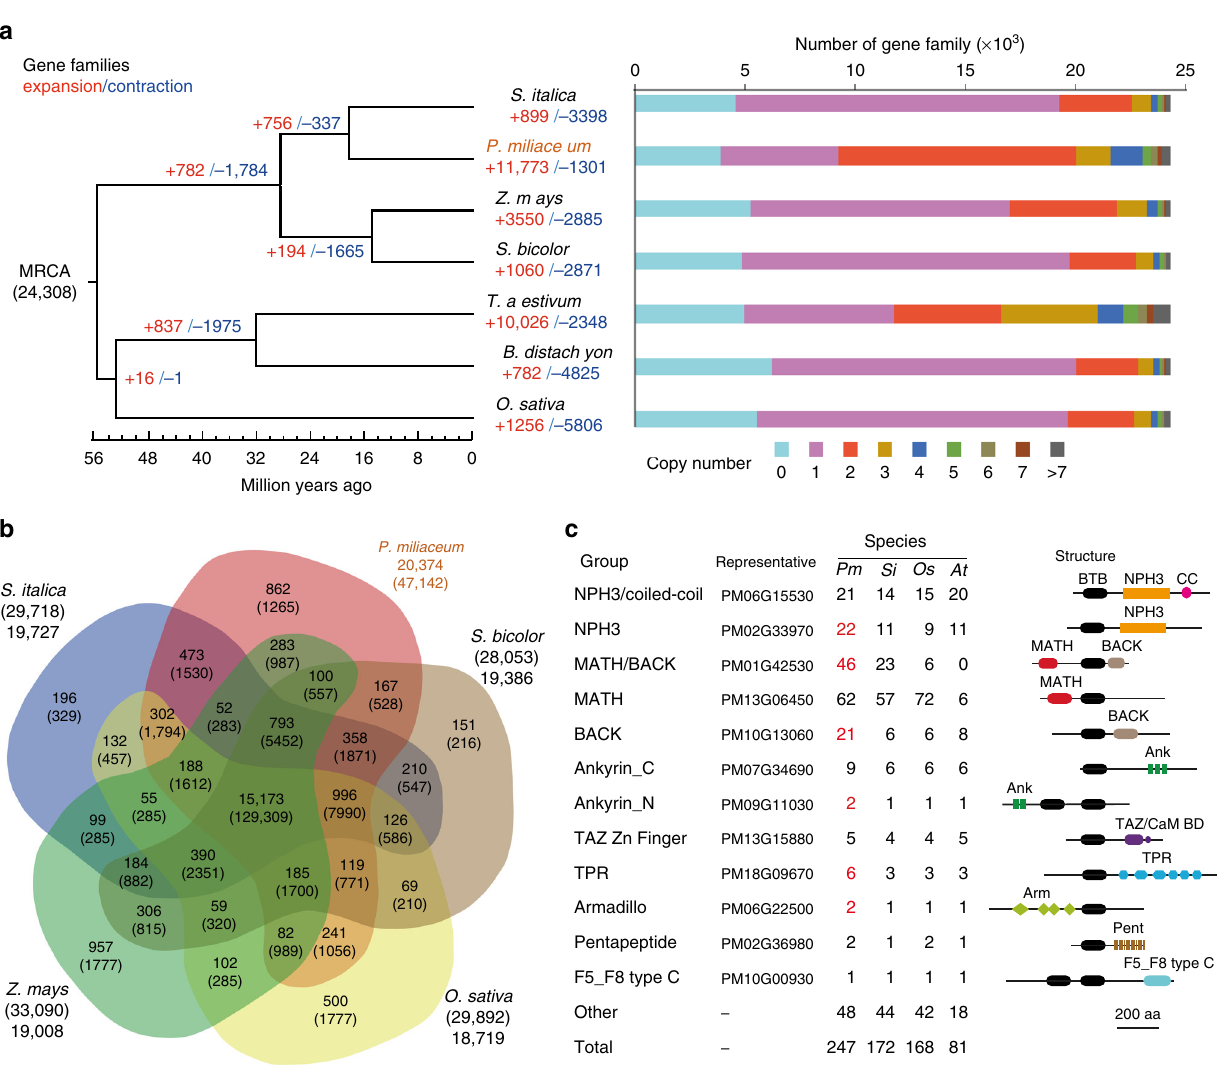
Fig. 3 Comparative genomics of gene families in broomcorn millet. a The number of gene families that expanded or contracted during evolution mapped to the species phylogenetic tree. b Overlap of gene families in broomcorn millet ( P. miliaceum ) and four other grasses. c Gene copy number and domain architecture of BTB proteins in broomcorn millet ( Pm ), foxtail millet ( Si ), rice ( Os ), and Arabidopsis thaliana (At). Gene copy numbers that are at least twofold higher in broomcorn millet ( P. miliaceum ) than in other species are labeled red. BTB broad complex/tramtrack/bric-a-brac, NPH3 nonphototropic- hypocotyl 3, MATH meprin-and-TRAF-homology, BACK BTB and C-terminal Kelch, TAZ Transcription Adaptor putative Zinc fi nger, TPR Tetratricopeptide repeat, F5_F8 type C discoidin